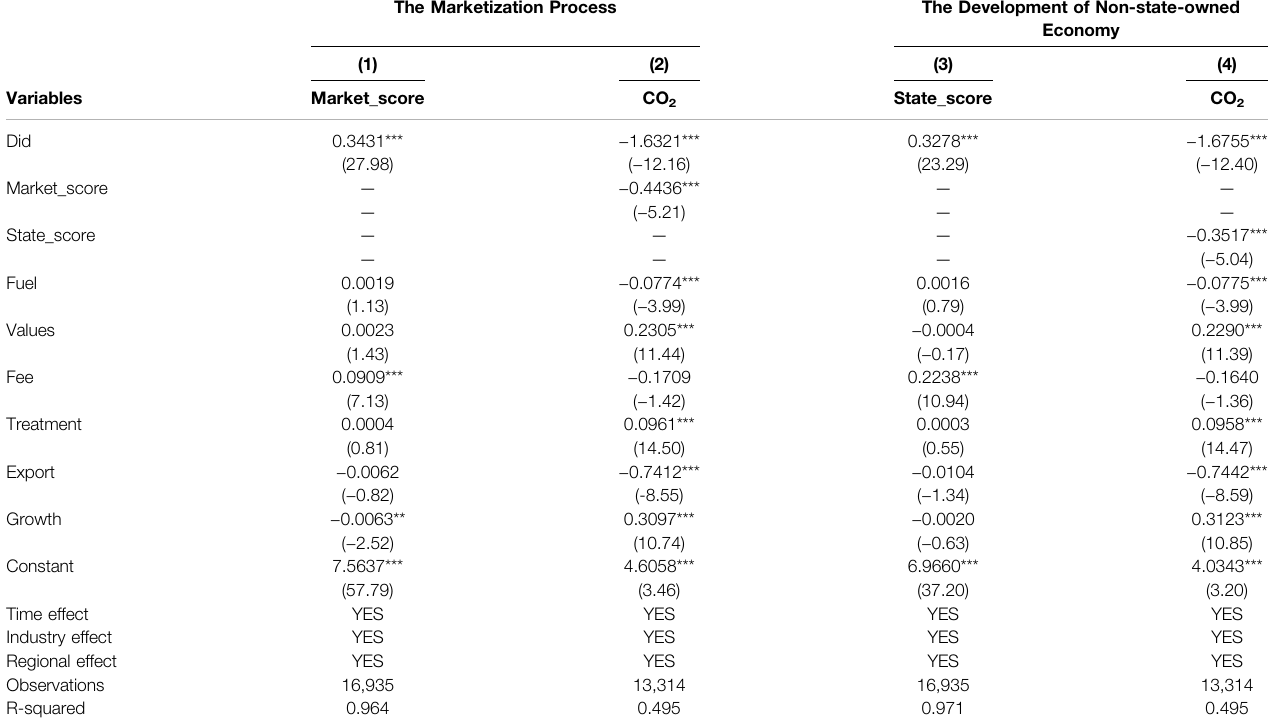
TABLE 7 | Mediation